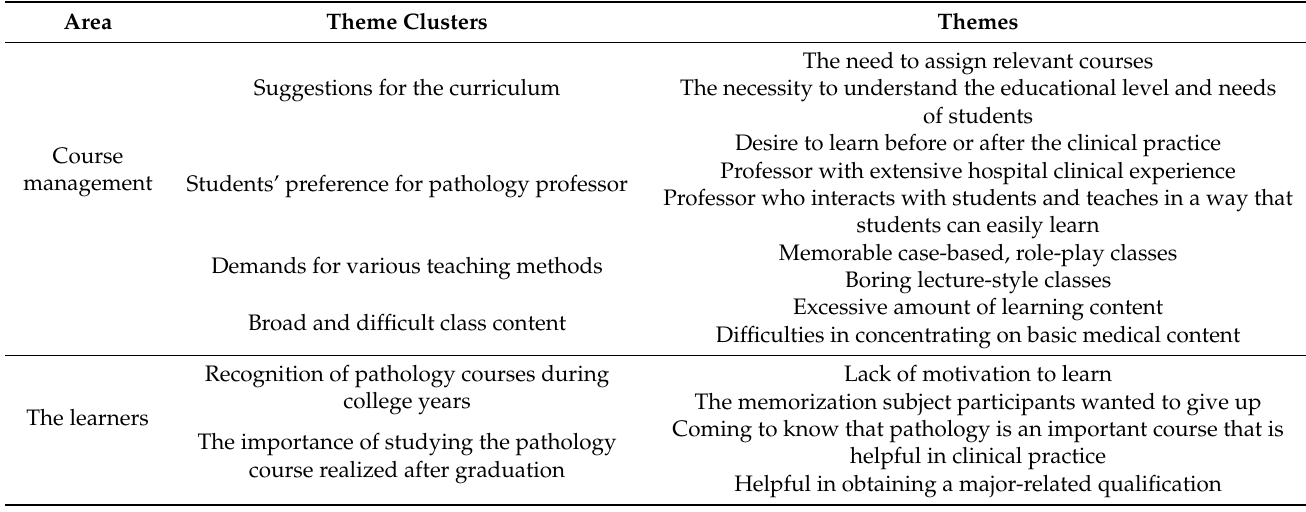
Table 3. Area, theme clusters, and themes of hospital management graduates’ pathology course experiences.